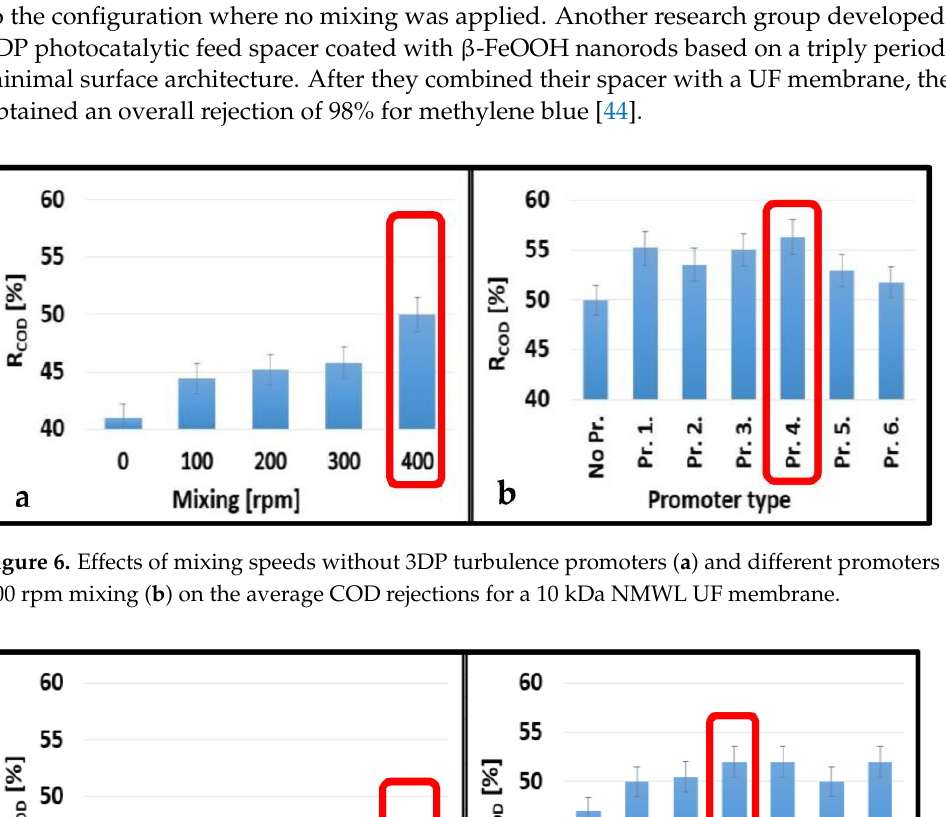
8 of 15 Figure 5. Ultrafiltration permeate flux values of 150 kDa membrane as a function of filtration time (T = 25 °C and TMP = 4 bar). 3.2. Ultrafiltration Membrane Rejections